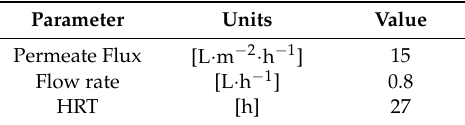
Table 2. Operational